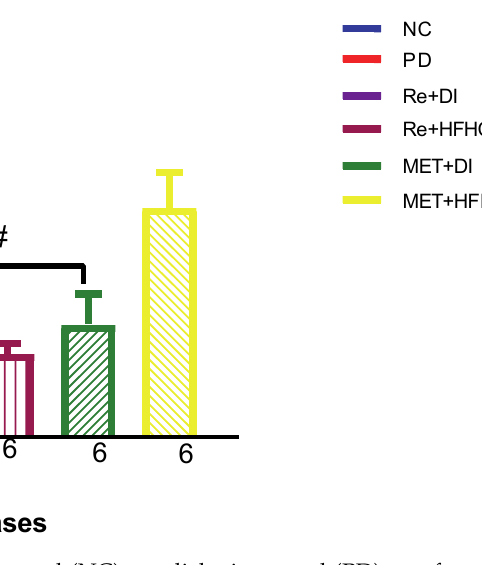
Figure 4. SOD activity in normal control (NC), prediabetic control (PD), metformin and diet inter- vention (MET + DI), metformin and high-fat/high-carbohydrate diet (MET + HFHC), rhenium (V) compound and diet intervention (Re + DI), and rhenium (V) compound and high-fat/high-carbohy- drate diet (Re + HFHC) groups after 12 weeks of treatment. Values are presented as means ± SEM (n = 6). p < 0.05 in comparison with NC; # p < 0.05 in comparison with PD, MET +DI, MET + HFHC, Re + DI and Re + HFHC.